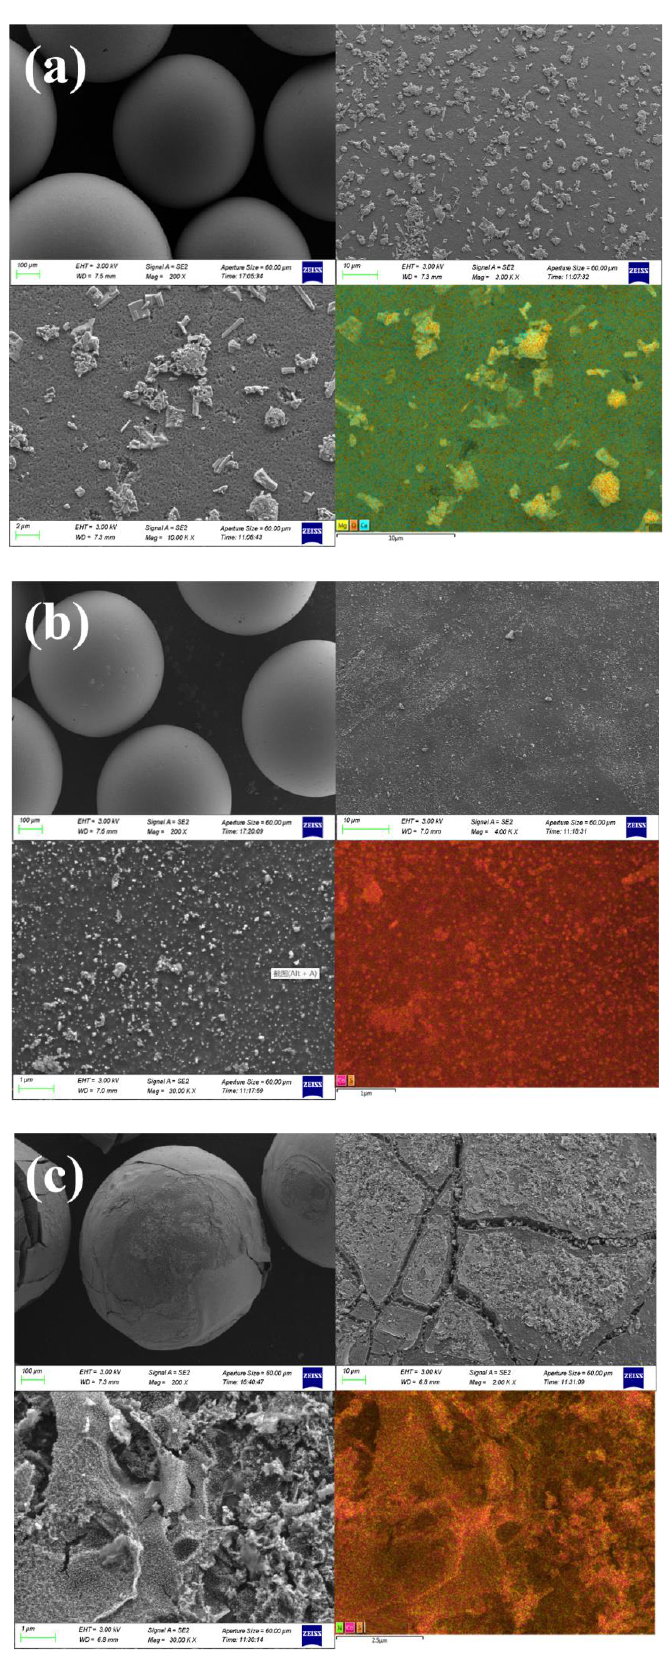
Figure 1. SEM and related EDS element layered images of D001CB ( a ); Co/D001CB ( c ); and N- Co/D001CB ( c